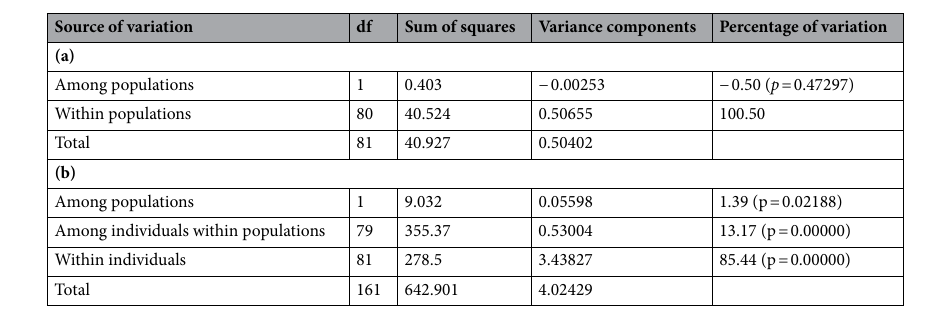
Table 2. Outcomes of the analysis of molecular variance (AMOVA) based on the variability of (a) mtDNA tRNA leu -cox2 intergenic region and (b) 14 microsatellite loci analysed in two types of honey bee colonies.